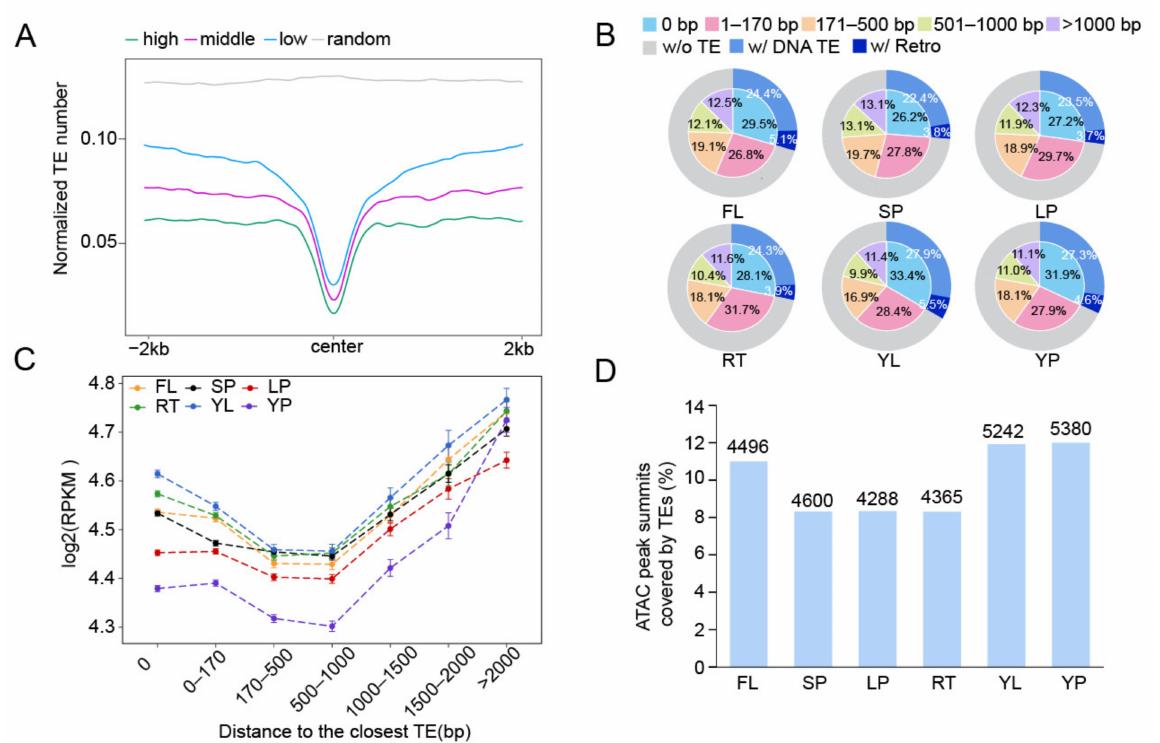
Figure 1. The TE-overlapping ACRs (accessible chromatin regions) in rice. ( A ) Curve plot showing normalized TE number across ± 2 kb of ACR center (in flag leaf). All ACRs were divided into three subgroups (high, mid, low) according to their levels of accessibility. The same number of randomly selected regions were used as control. ( B ) Pie plot showing the ratio of ACRs with different distances to the nearest TEs (0 bp, representing ACRs with at least 1 bp overlap with TEs, 1~170 bp, 171~500 bp, 501~1000 bp, >1000 bp) in six tissues (FL, flag leaf; SP, stamen & pistil; LP, lemma & palea; RT, root; YL, young leaf; YP, young panicle), 26.2% (SP) to 33.4% (YL) ACRs had at least 1 bp overlap with TEs ( w/o represents “without”, w/ represents “with”). ( C ) The accessibility of ACRs with different distances to the nearest TEs in six tissues, the reads of ATAC-seq within ACRs were normalized by reads per kilobase per million mapped reads (RPKM). ( D ) Bar plots illustrating the ratio and number of ACRs with their summits covered by